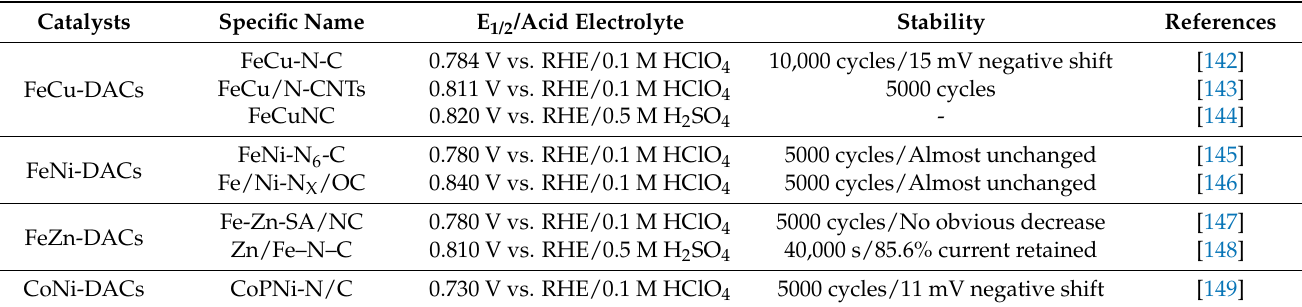
Table 2. Summary of the ORR performance for other metal